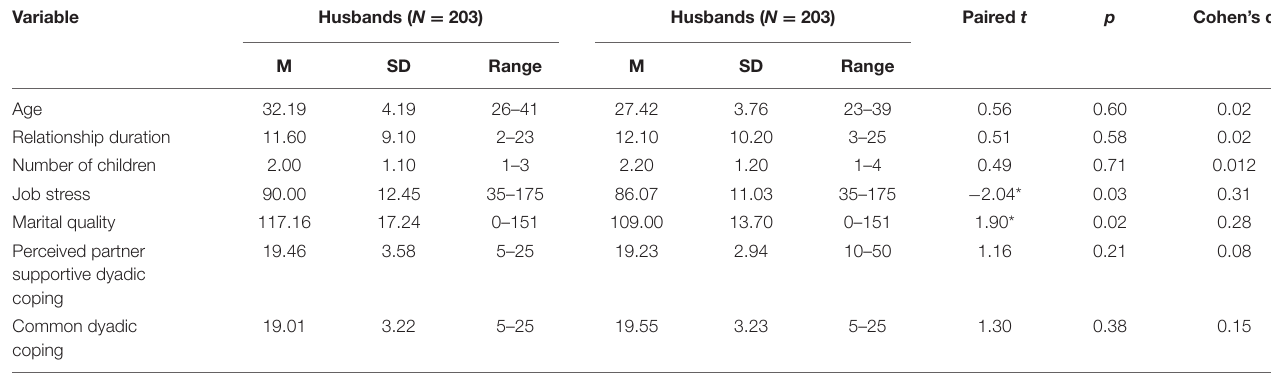
TABLE 1 | Descriptive of study